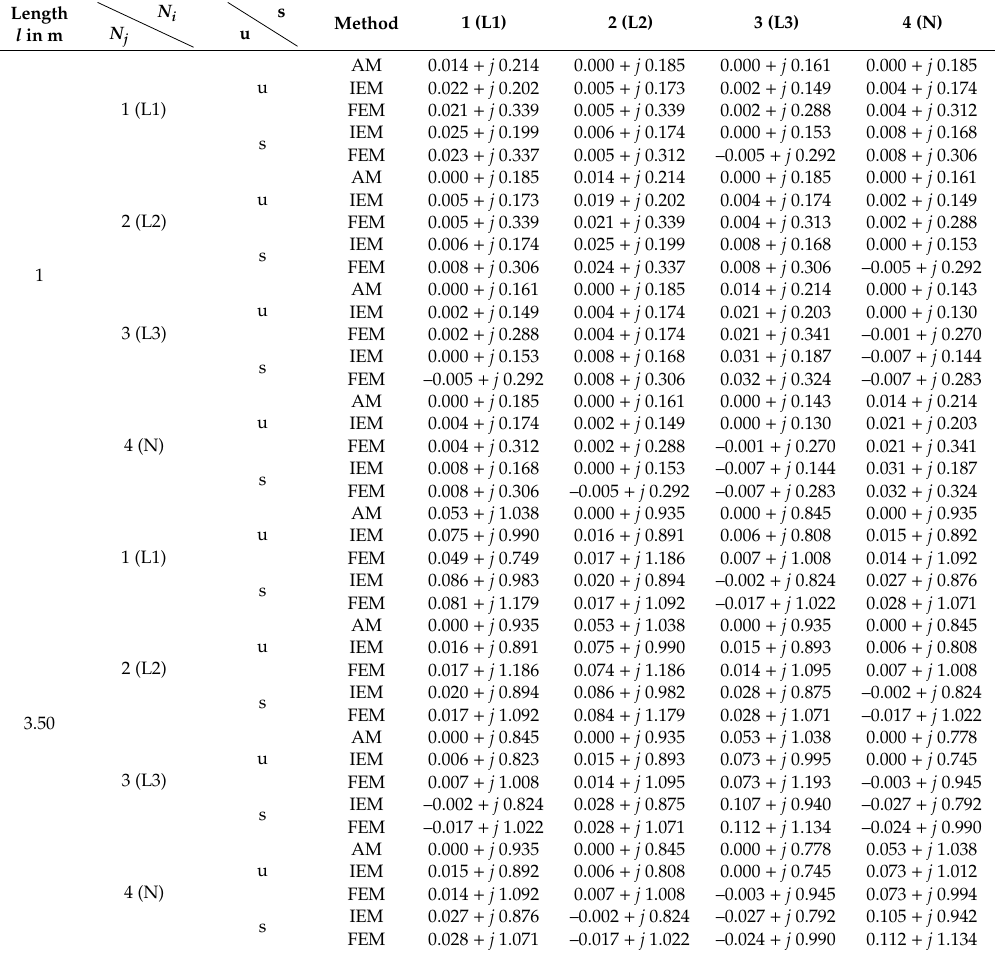
Table 1. Self and mutual impedances in m Ω of the unshielded (u) and shielded (s) three-phase busbar systems illustrated in Figures 2 and